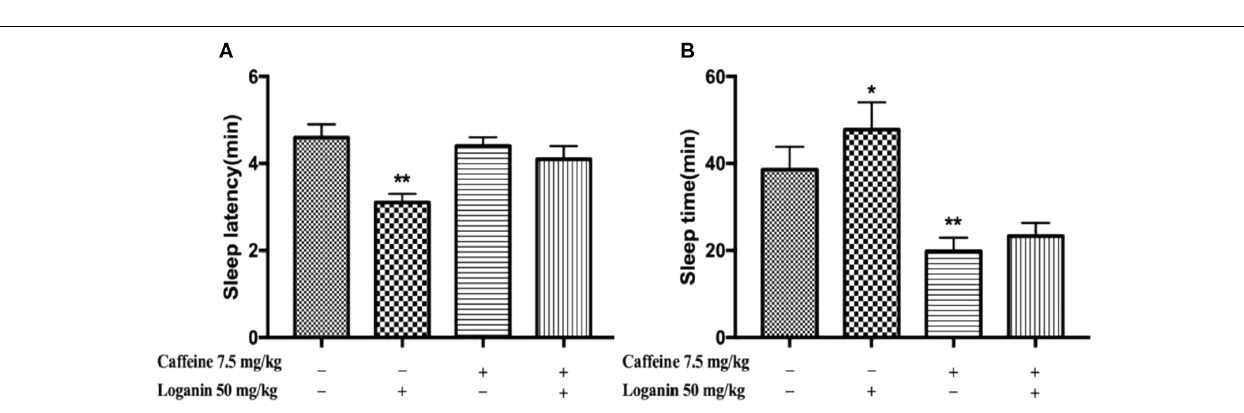
FIGURE 4 | Effect of loganin on the hypnotic response to pentobarbital-induced sleep in mice. The sleep latency (A) and the sleep time (B) were measured. Data are presented as mean ± SEM ( n = 12). ∗ P < 0.05, ∗∗ P < 0.01, vs. the control group (one-way ANOVA followed by Student-Newman-Keuls test).